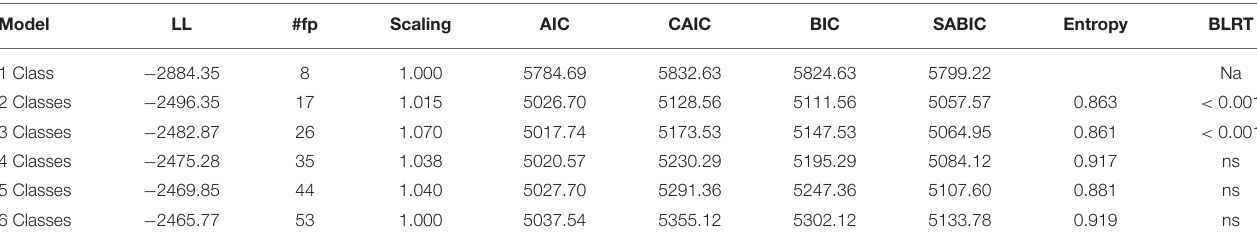
TABLE 2 | Fit indices for LCA models with 1–5